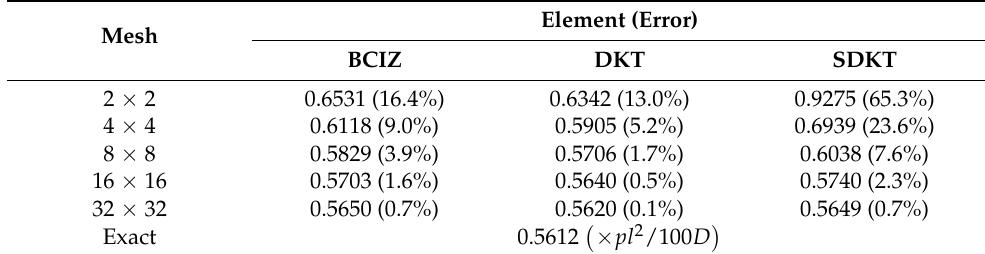
Table 5. Central deflection for a clamped square plate under center point load.